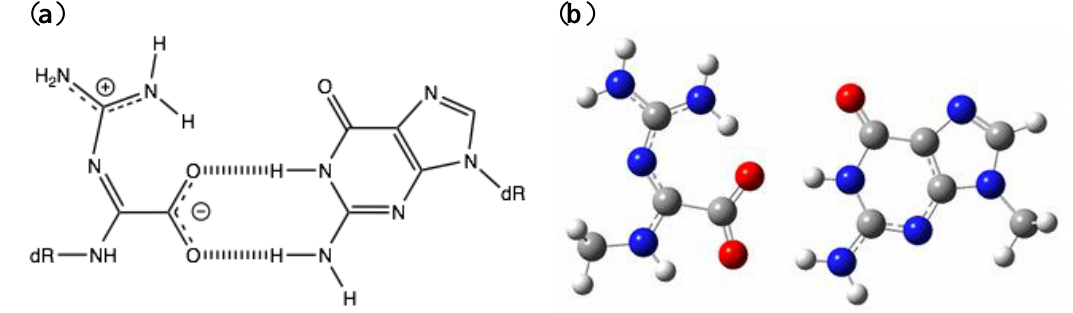
Figure 4. The Oz:G base pair. ( a ) The proposed Oz:G base pair; ( b ) The geometries of Oz:G optimized by ab initio calculation. The stabilization energies are shown in Table